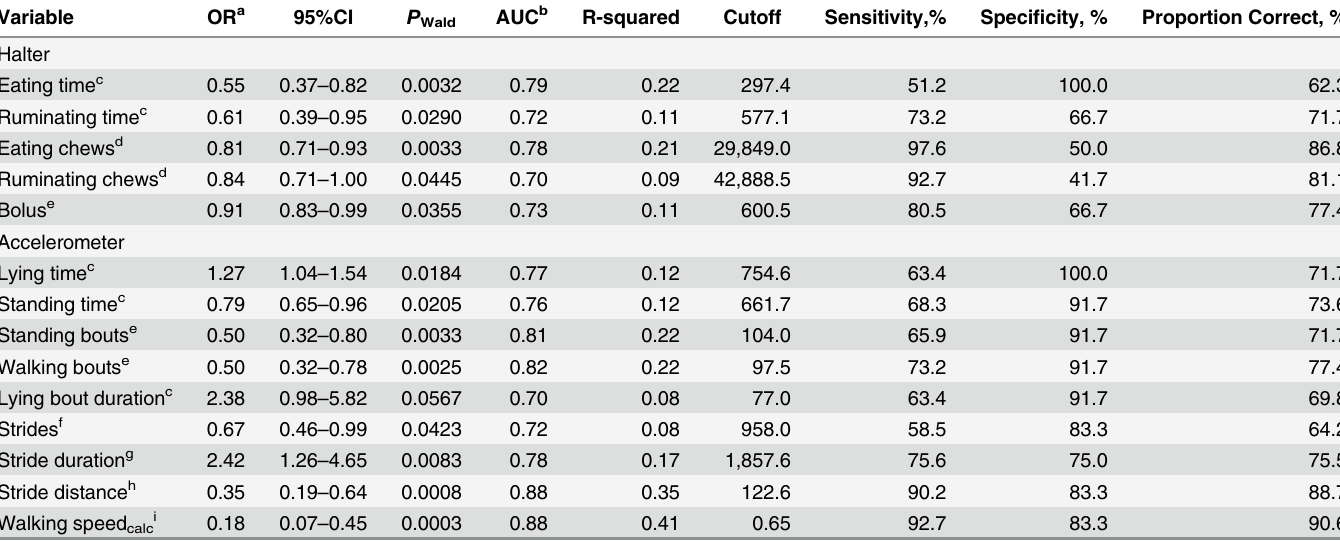
Table 4. Results of univariable logistic regression and receiver operating characteristics analysis of a cow being lame (numerical rating system according to Flower and Weary [38], NRS (cid:1) 2.5) using different RumiWatch noseband sensor and accelerometer (RumiWatch, ITIN+HOCH GmbH, Fütterungstechnik, Liestal, Switzerland) variables as predictors on the cutoff value with highest sensitivity +